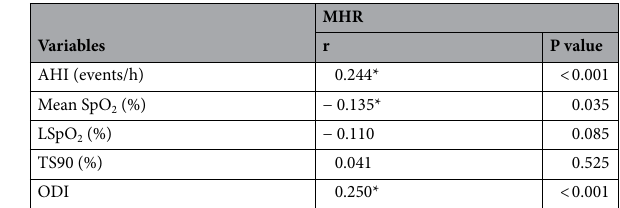
Table 3. Correlations between OCST parameters and MHR. OCST out of center sleep testing, MHR monocyte to high-density lipoprotein cholesterol ratio, AHI apnea–hypopnea index, Mean SpO 2 mean oxygen